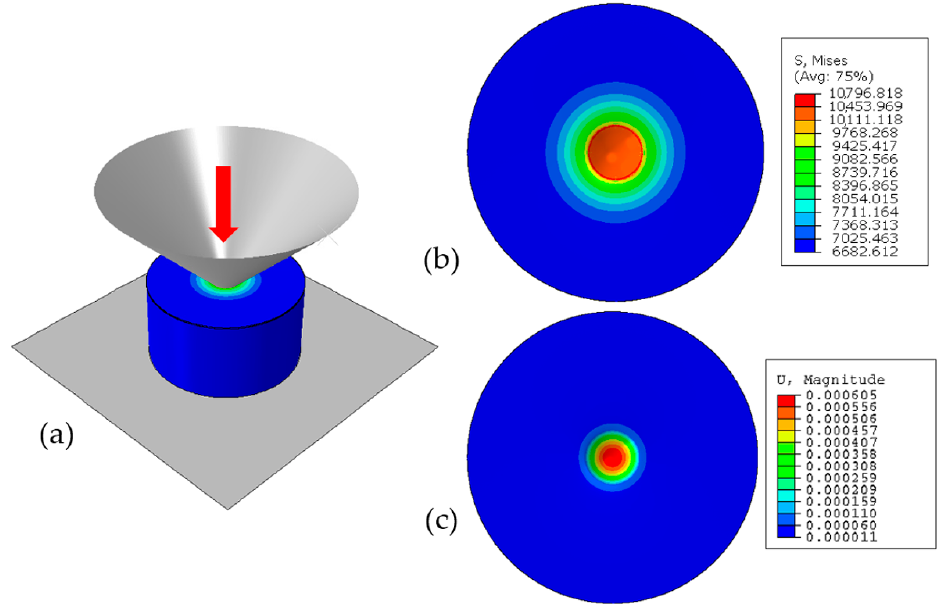
Figure 10. Distribution of ( a ) equivalent stress (MPa) in the model from the side view and, ( b ) equivalent stress (MPa), ( c ) displacement (mm) from the top view.